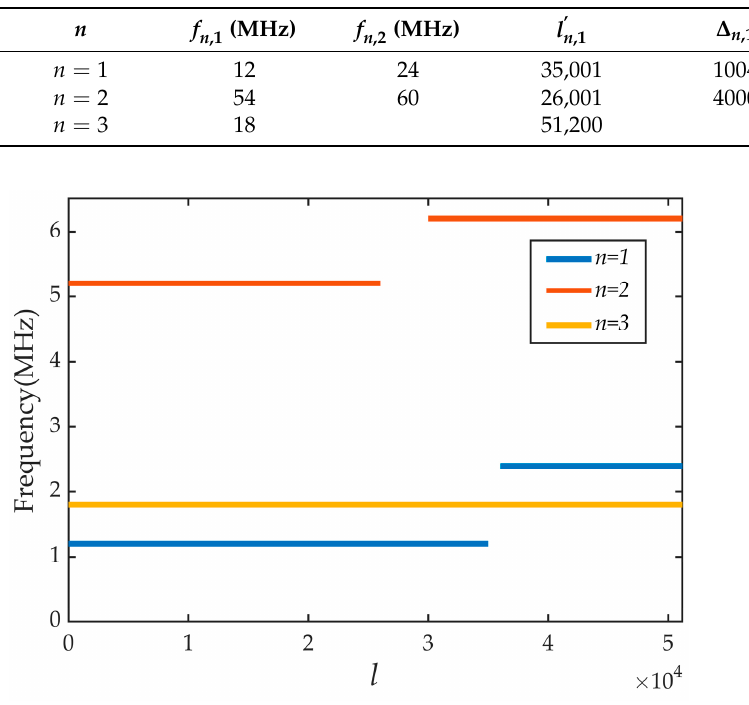
5.811×10 - 5 . As shown in Figure 17b, the average CPU time consumed by the CSOMP-ASW algorithm is 0.768 s, while that of the CSML algorithm is 0.3032 s. Therefore, the CSML algorithm can perform fast and accurate estimation of the parameters of multiple FH sig- nals with frequency-switching time.